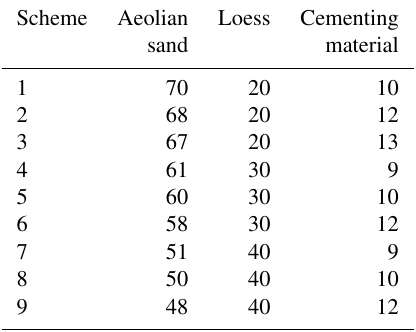
Table 1. Testing scheme.